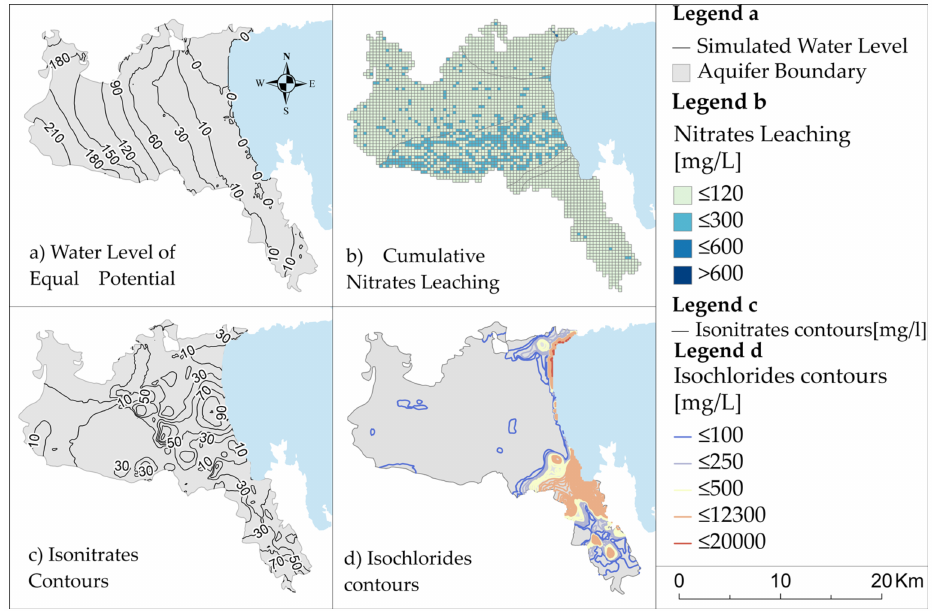
Figure 2. Results of previous groundwater simulation for existing agricultural and water manage- ment conditions and water supplied by groundwater pumping: ( a ) hydraulic heads, ( b ) nitrate leaching, ( c ) chloride concentrations, and ( d ) nitrate concentration in September 2018 (as simulated by Lyra et al. 2021